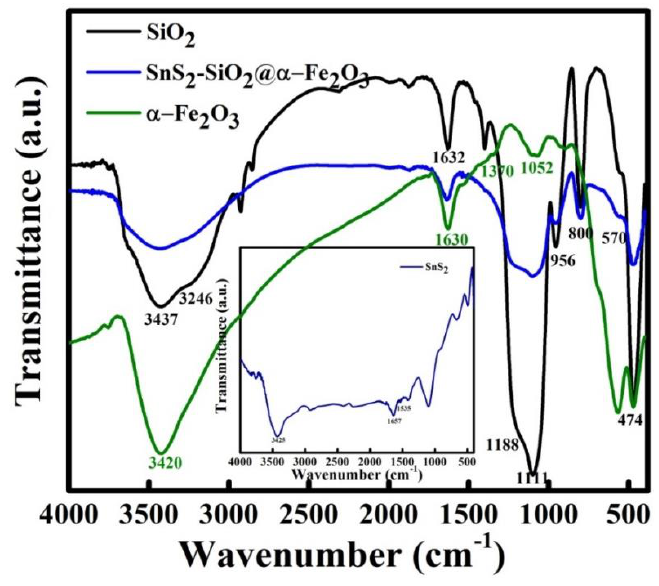
Figure 7. FTIR spectra of SiO 2 , α -Fe 2 O 3 , and SnS 2 -SiO 2 @ α -Fe 2 O 3 composites; inset shows the SnS 2 spectra.